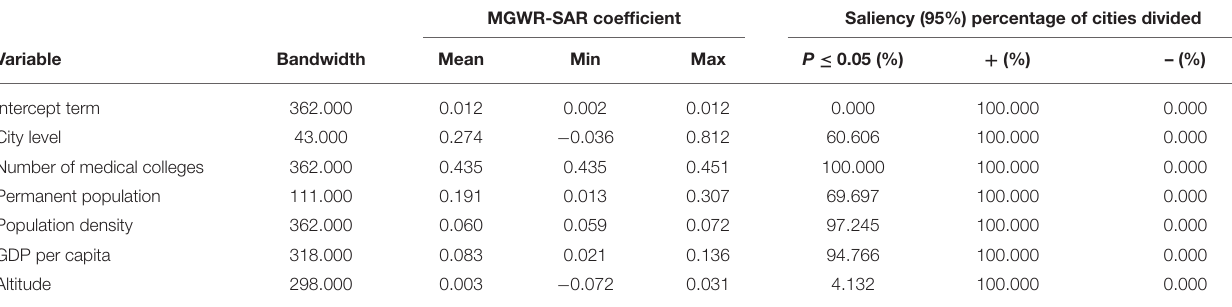
TABLE 7 | Parameter estimates for the regression of number of elite hospitals using MGWR-SAR. MGWR-SAR coefficient Saliency (95%) percentage of cities divided